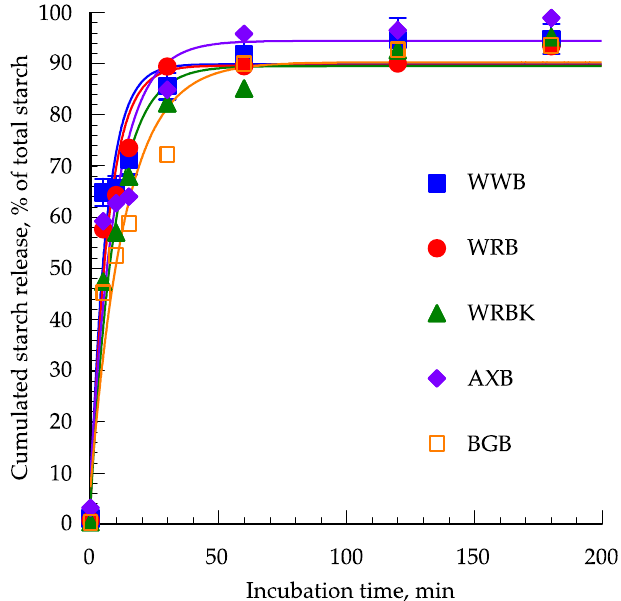
Figure 2. In vitro cumulative starch hydrolysis (% of total dry starch) of the white wheat bread (WWB), whole grain rye bread (WRB), whole grain rye bread with kernels (WRBK), arabinoxylan bread (AXB) and the beta-glucan bread (BGB). Values are the means ± SEM ( n = 3). Foods 2020 , 9 , x FOR PEER REVIEW The highest hydrolysis rate was between 0 and 5 min and with decreasing rates thereafter. In this period, the highest hydrolysis rate was found for WWB (13.9% starch/min), followed by WRB (10.4% starch/min), WRBK (8.7% starch/min) and finally AXB and BGB (7.4–8.5% starch/min) (Figure